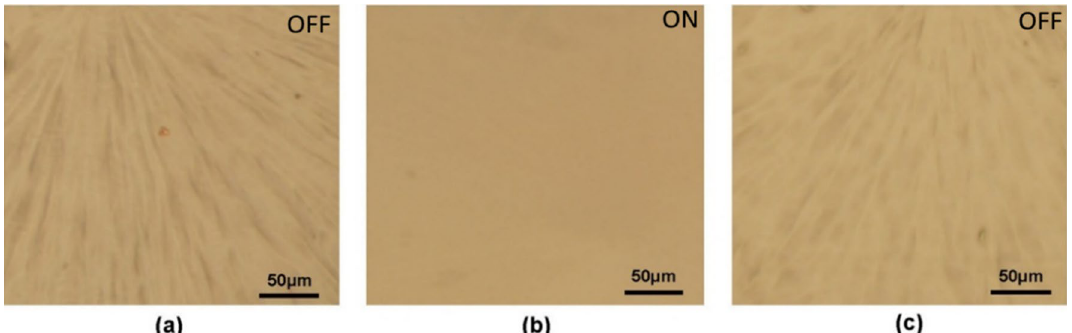
Figure 7. Infrared light-driven INCP film shown by optical microscopy